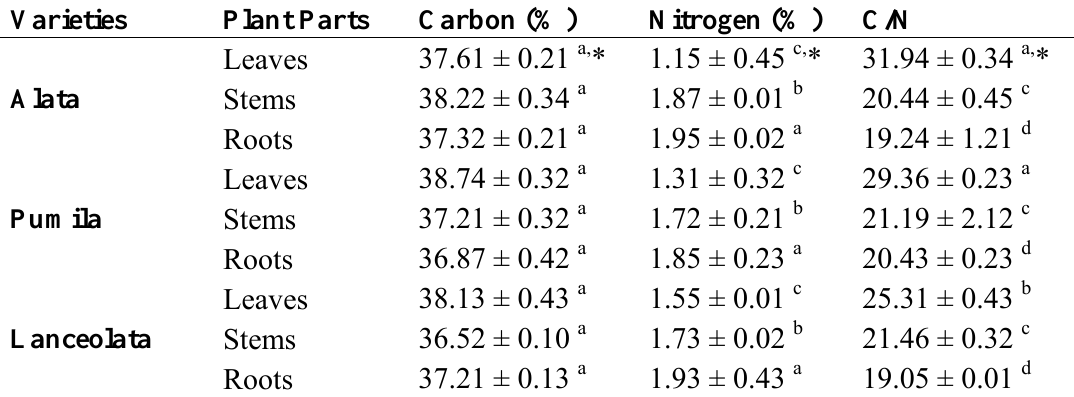
Table 4. Total carbon, nitrogen and C/N in different parts of three varieties of L. pumila